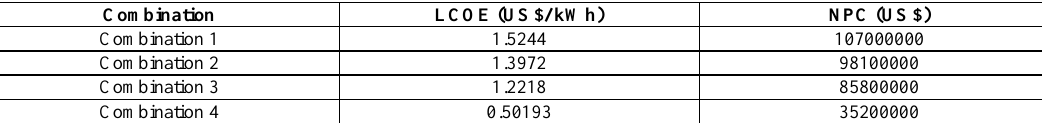
Table 3. LCOE and NPC comparison of combination 1, 2, 3 &